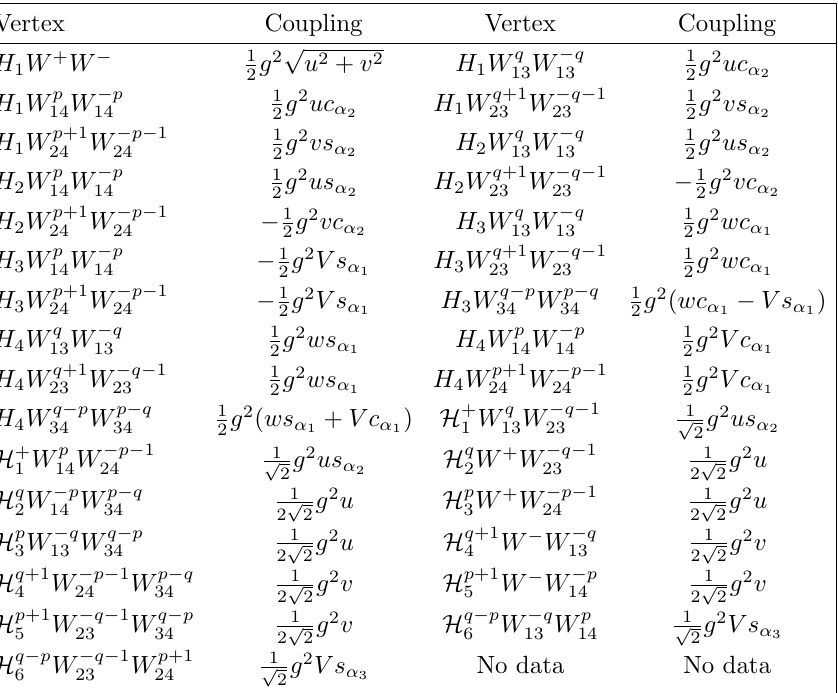
Table 9 . The interactions of a scalar with two charged gauge bosons.